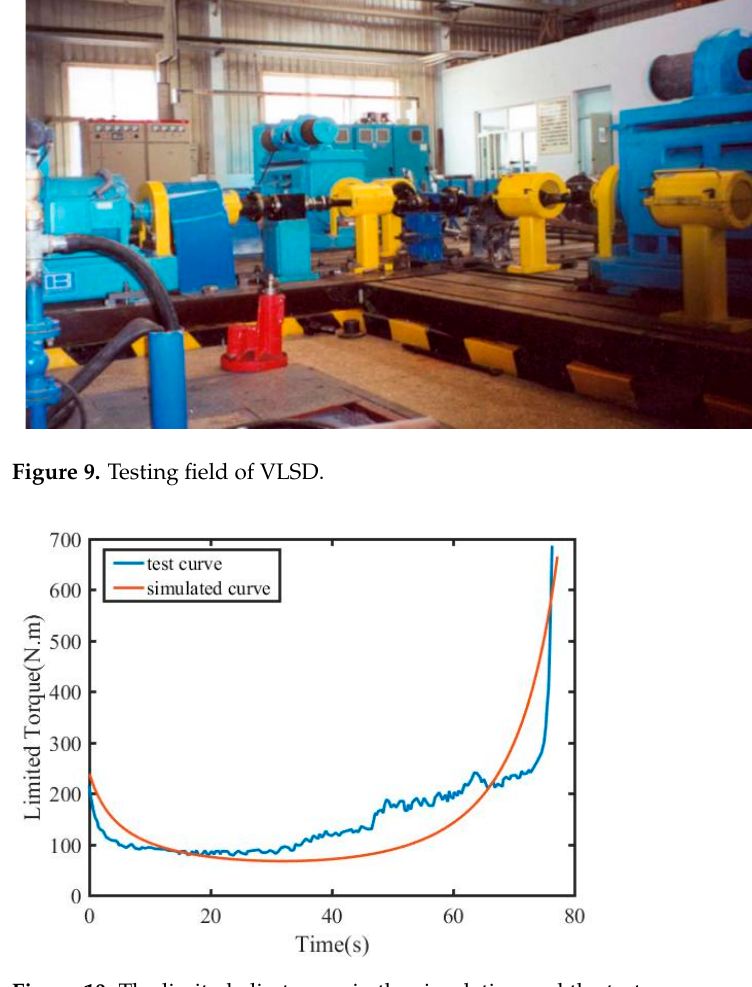
Figure 10. The limited-slip torque in the simulation and the test.